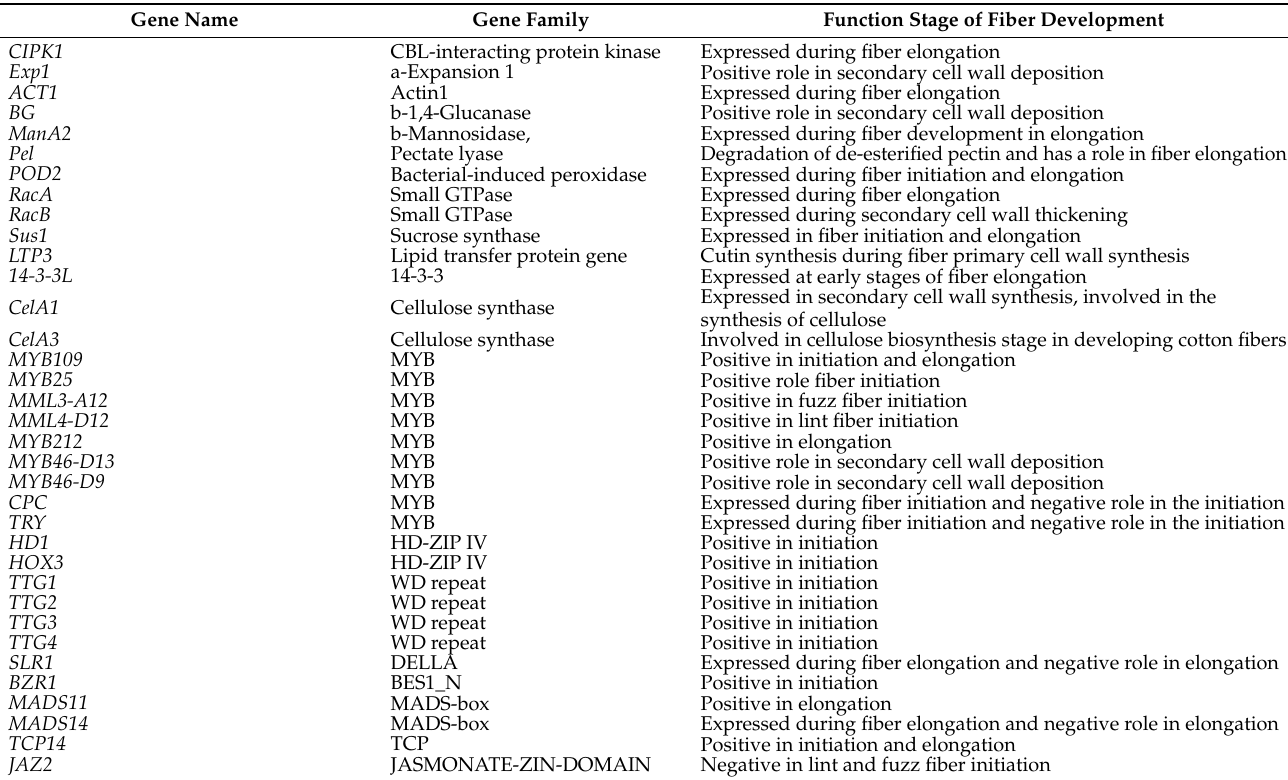
Table 1. The role of genes involves different stages of fiber